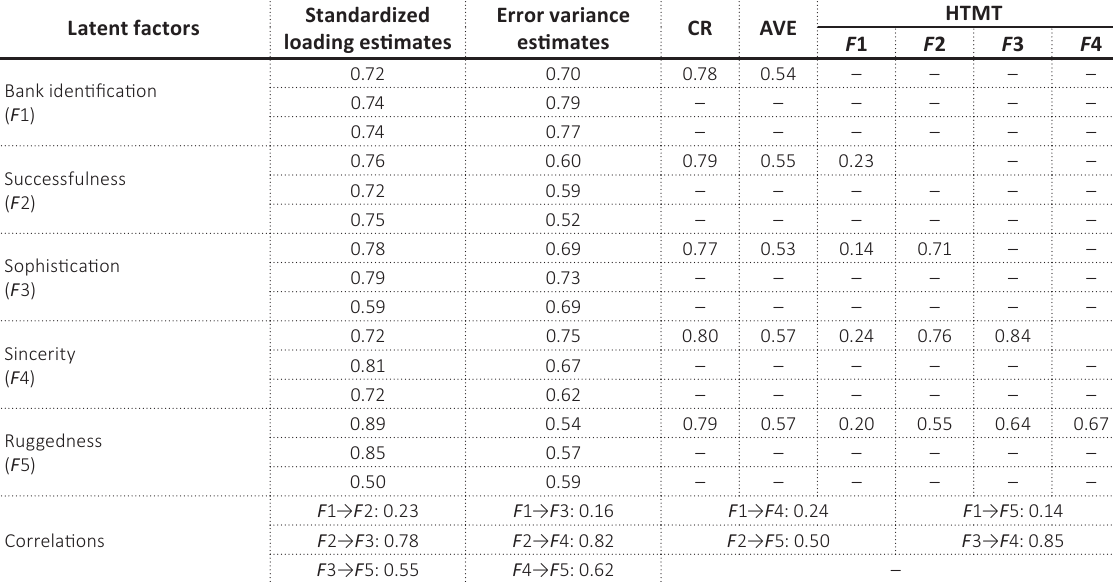
Table 3. Confirmatory factor analysis Latent